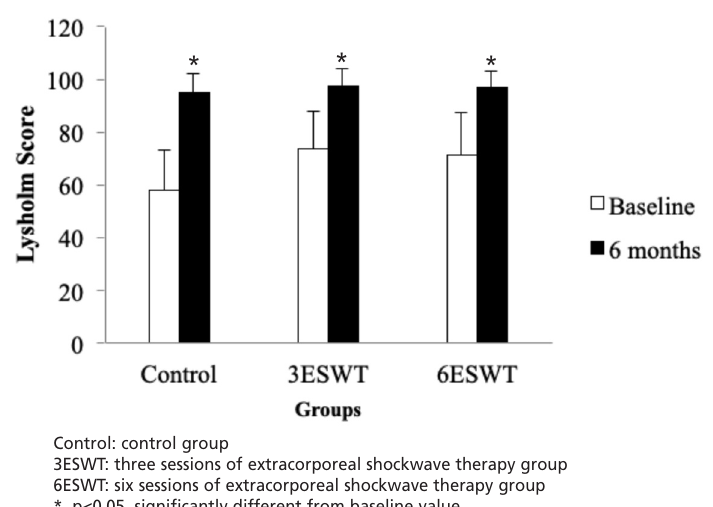
Means Lysholm score which reflect participant’s knee functions at baseline and six months post-operatively in control, 3ESWT Fig. 3: and 6ESWT groups